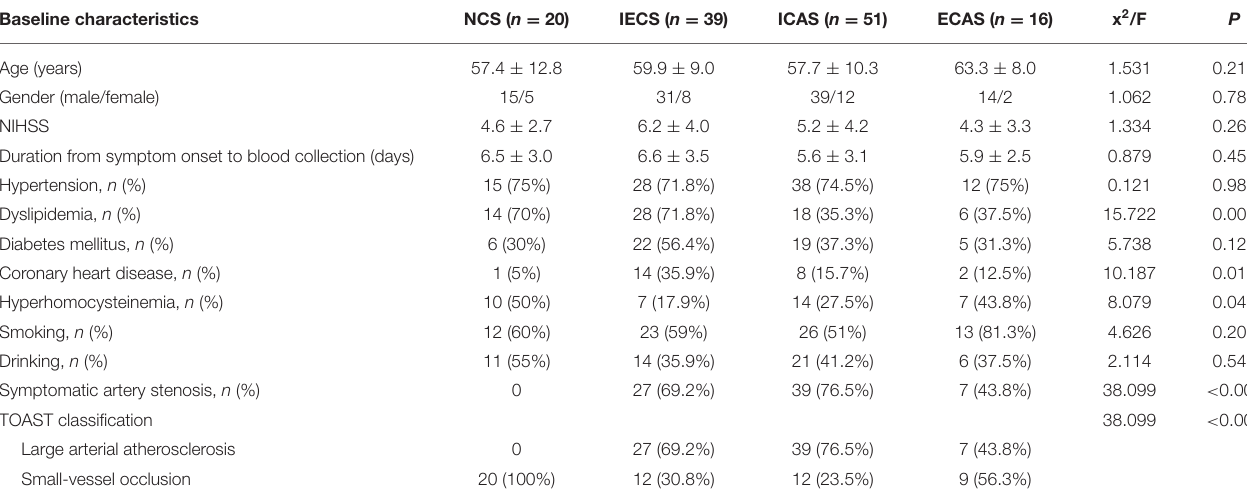
TABLE 2 | Clinical characteristics of patients according to the location of arterial stenosis. Baseline characteristics